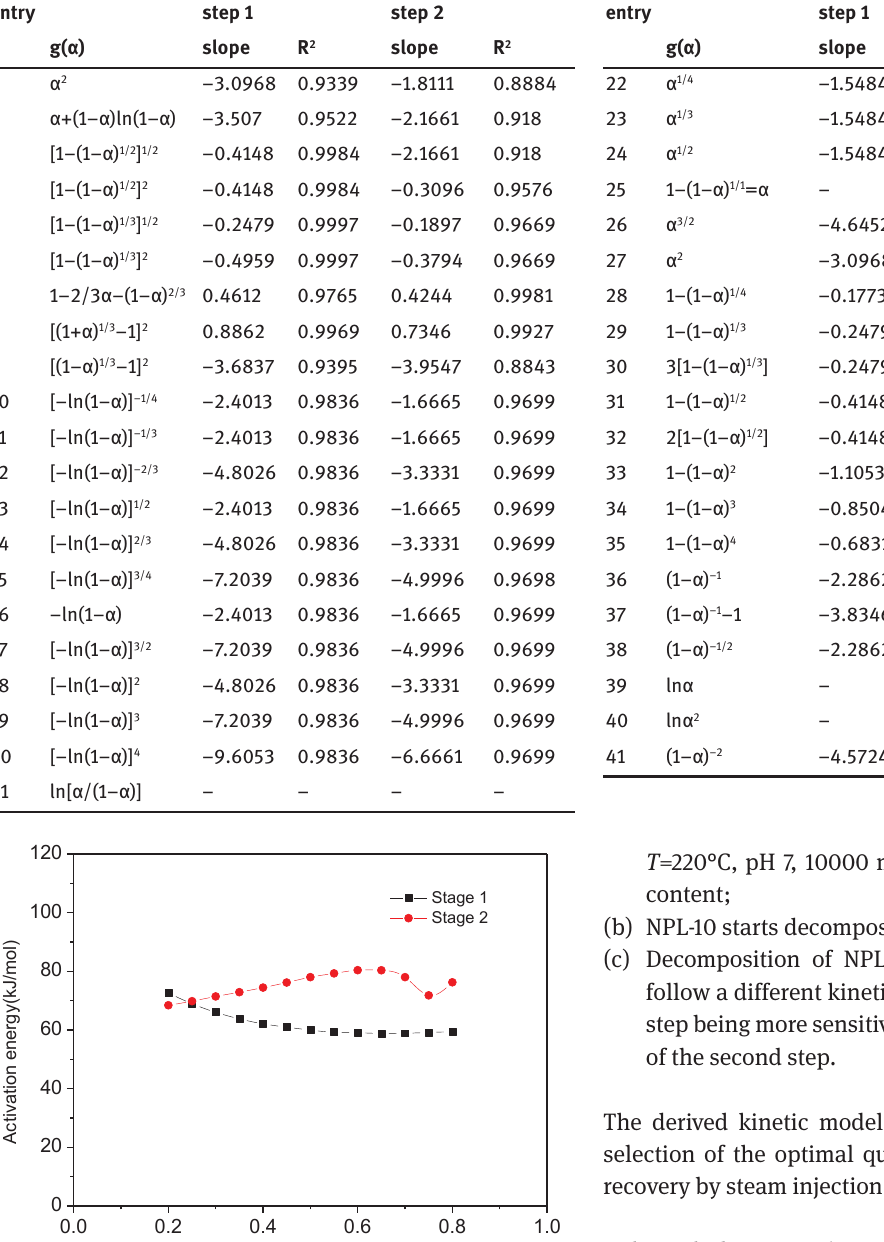
Table 3: Linear regression analysis of 41 kinetic functions for steps 1 and